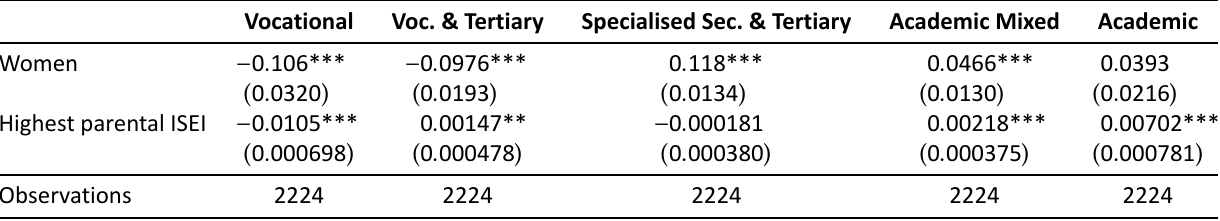
Table 3. Probability of belonging to a certain educational cluster (average marginal effects based on multinomial logistic regression). Source: PISA (2000) and TREE waves 1–9 (weighted; 2016).